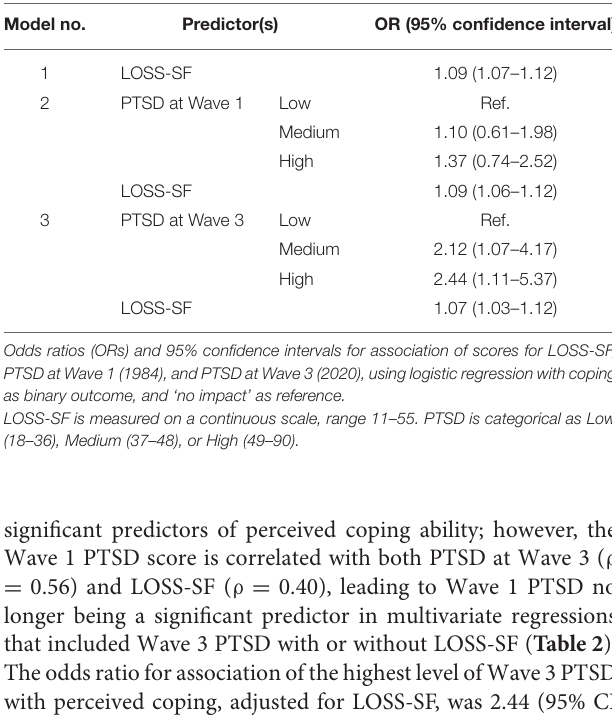
TABLE 1 | Characteristics of 422 study respondents who completed the COVID supplement to the Wave 3 Survey*.